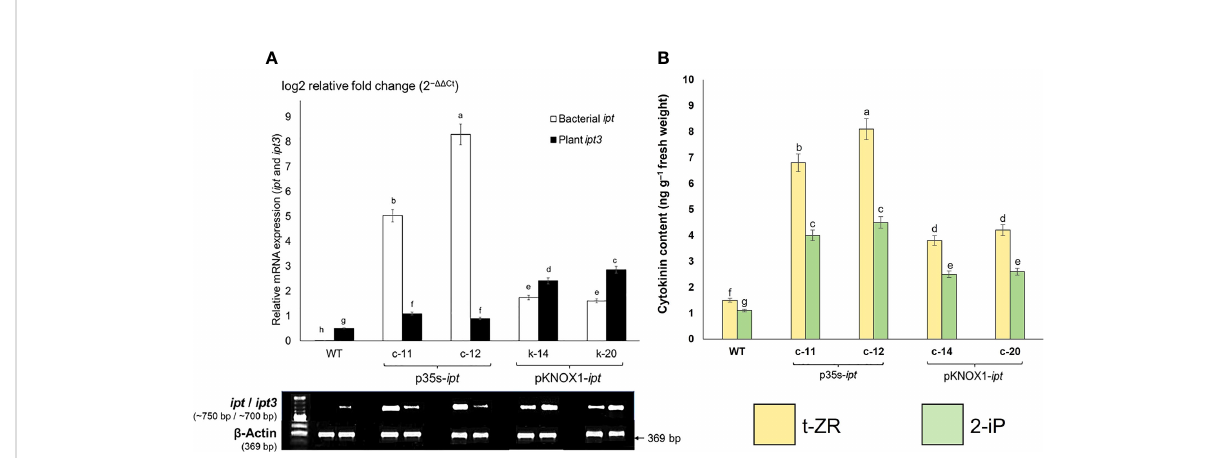
FIGURE 4 Transcriptomic expressions of cytokinin biosynthetic genes (A) comprise with bacterial ipt (GenBank accession number: KJ634148) and ipt3 (isopentenyltransferase; GenBank accession number: TR435612); and cytokinin contents (B) . Quantitative RT-PCR showing relative mRNA expressions determined using the 2 ( − DD Ct) method, threshold cycles (Ct) for target genes are standardized to the Beta-actin Ct ( D Ct). Transcriptomic expressions of bacterial ipt (white bar) and plant ipt3 (black bar) in wildtype (WT) and transgenic P. pellucida were compared. Four transgenic lines derived from different promoters; pCaMV35S (c-11, c-12 lines) and pKNOX1 (k-14 and k-20 lines). Gel electrophoresis of mRNA levels were determined using Beta-actin as reference and 1 kb molecular marker (A) . The amounts of endogenous cytokinin (B) were determined by ELISA using monoclonal antibodies by following the protocol provided by the manufacturer (Phytodetek, Agdia, Elkhart, IN, USA). The levels of trans-zeatin riboside (t-ZR) and isopentenyladenine (2-iP) were examined in WT and four lines of transgenic P. pellucida . Different letters of (A) and (B) indicate highly signi fi cant differences of means ( ± SE) analyzed by using Duncan ’ s Multiple Range Test (DMRT) at p ≤ 0.01. The experiment was performed using fi ve biological replications per treatment and three experimental